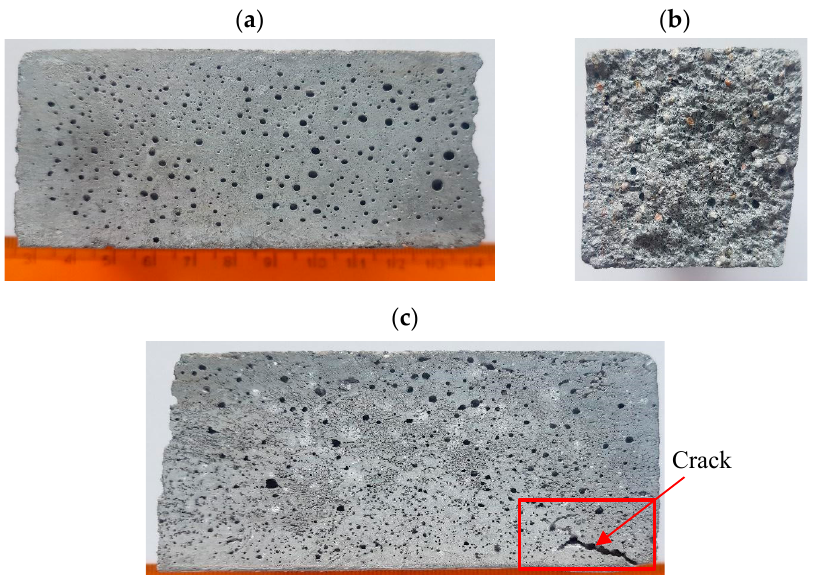
Figure 9. Cement mortar with the addition of 8% fly ash modified with nanosilica: ( a ) outer surface; ( b ) internal structural view; ( c ) crack in the cement mortar.